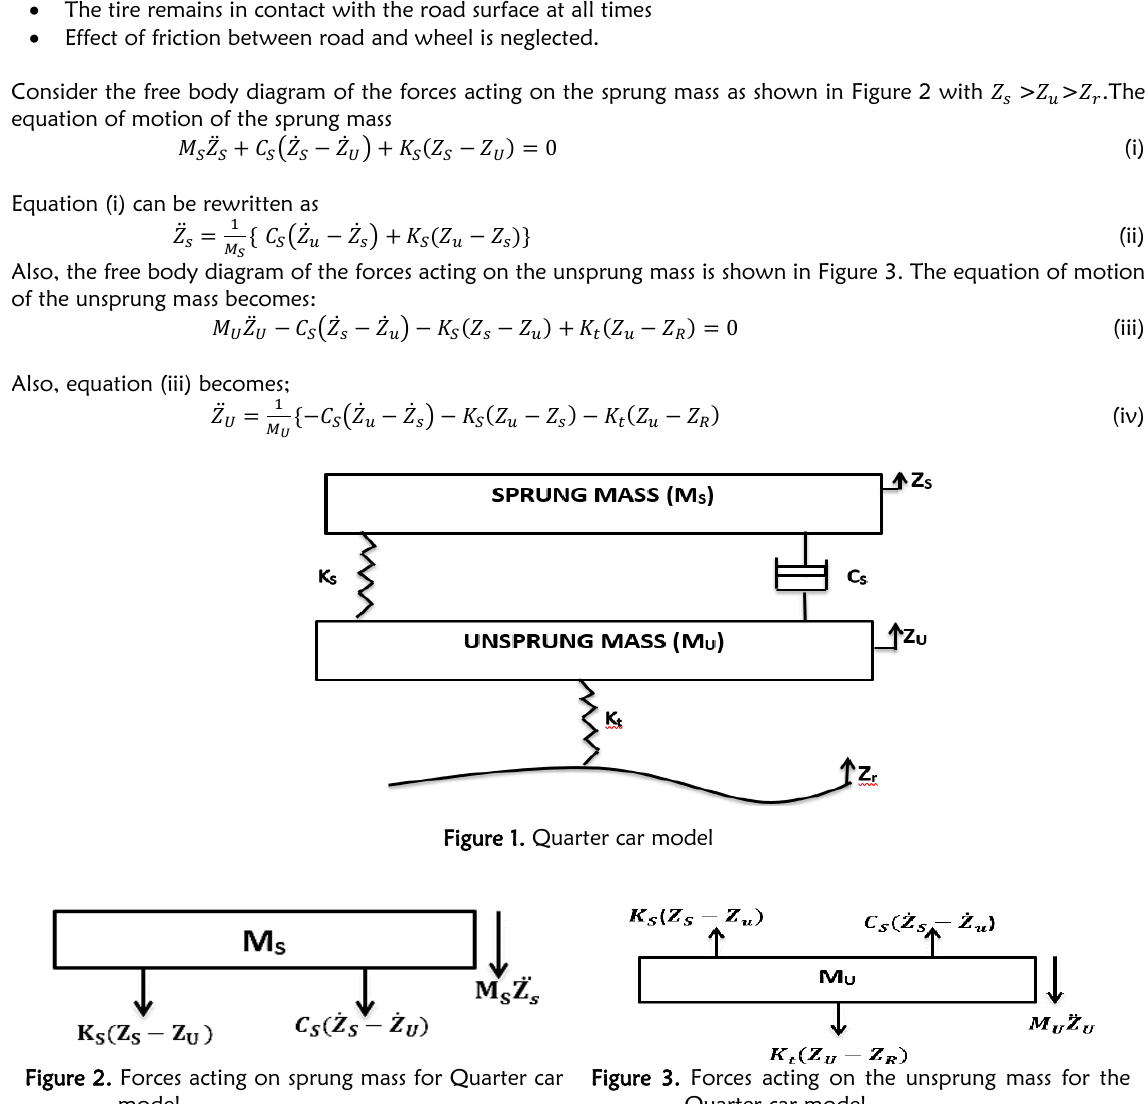
Figure 2. Forces acting on sprung mass for Quarter car model